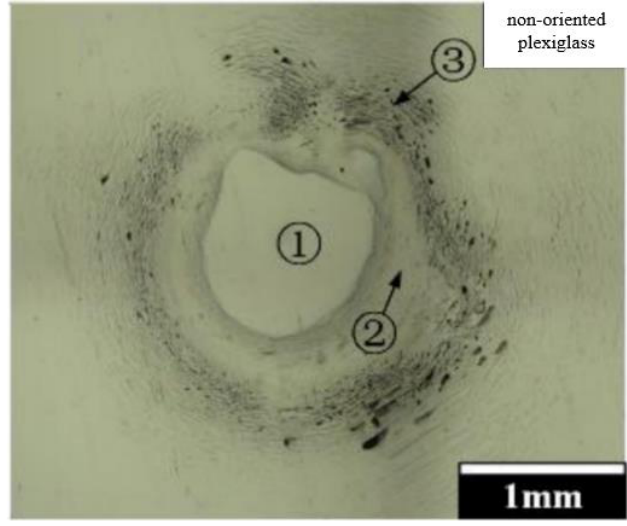
Figure 3. Microscopic images of the surface of two plexiglass samples after jet impact.